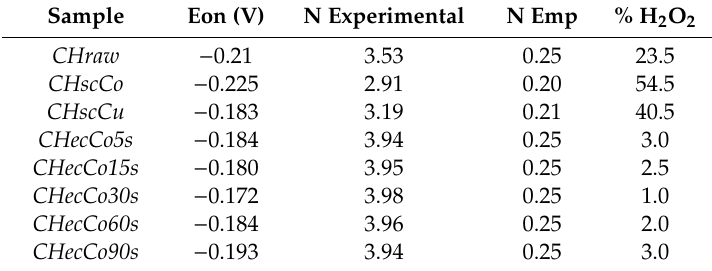
Table 3. Synopsis of electrolytic data collected from sonochemical and electrochemical deposition of Co and